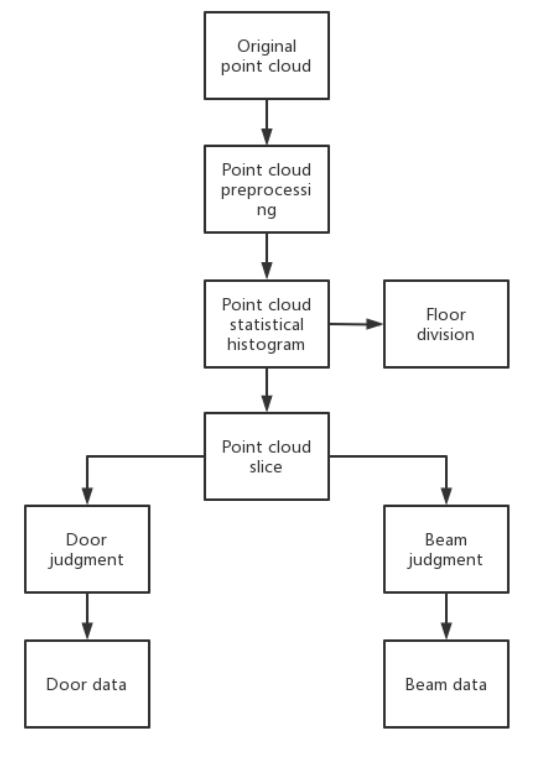
Figure 1. Overall process of experiment